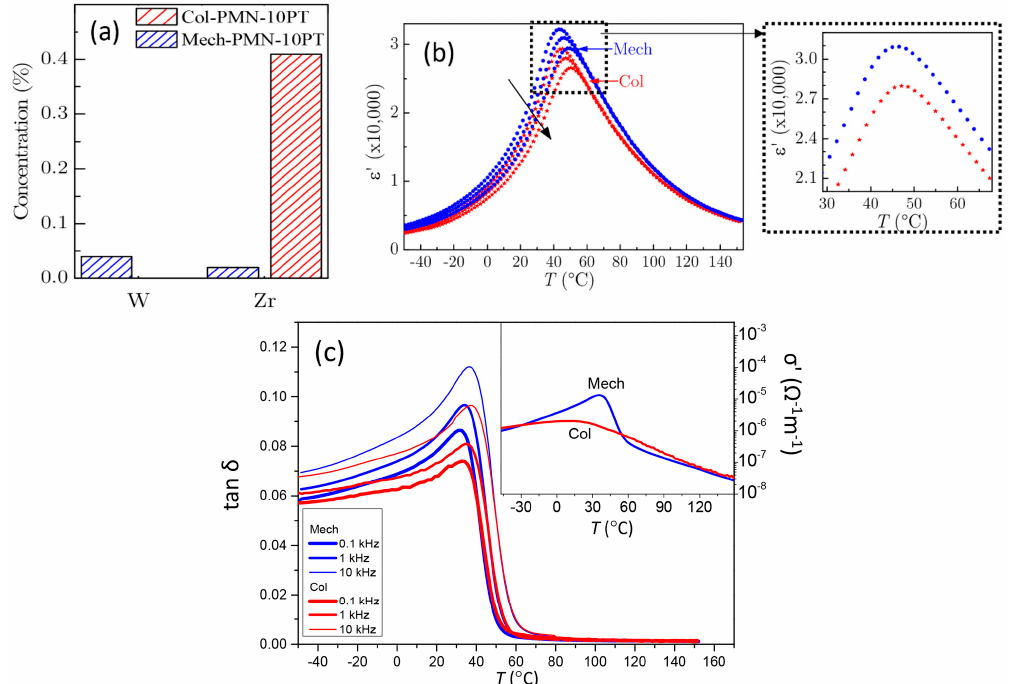
Figure 4. ( a ) Concentrations of contaminants in the PMN-10PT powder due to the wear of the milling bodies, determined by ICP spectrometry. Concentration is given in mole of contaminant per mole of PMN-10PT (in %). Temperature dependence of the ( b ) 𝜀′ and ( c ) tan 𝛿 at 0.1, 1, and 10 kHz for the Col (red stars) and Mech (blue circles) ceramics. The black arrow in ( b ) indicates the increasing frequency. Inset in ( b ): smaller scale of the 𝜀′(𝑇) at 1 kHz. Inset in ( c ): The specific electrical conductivity σ ' for both samples calculated from the dielectric data at 0.1 kHz.